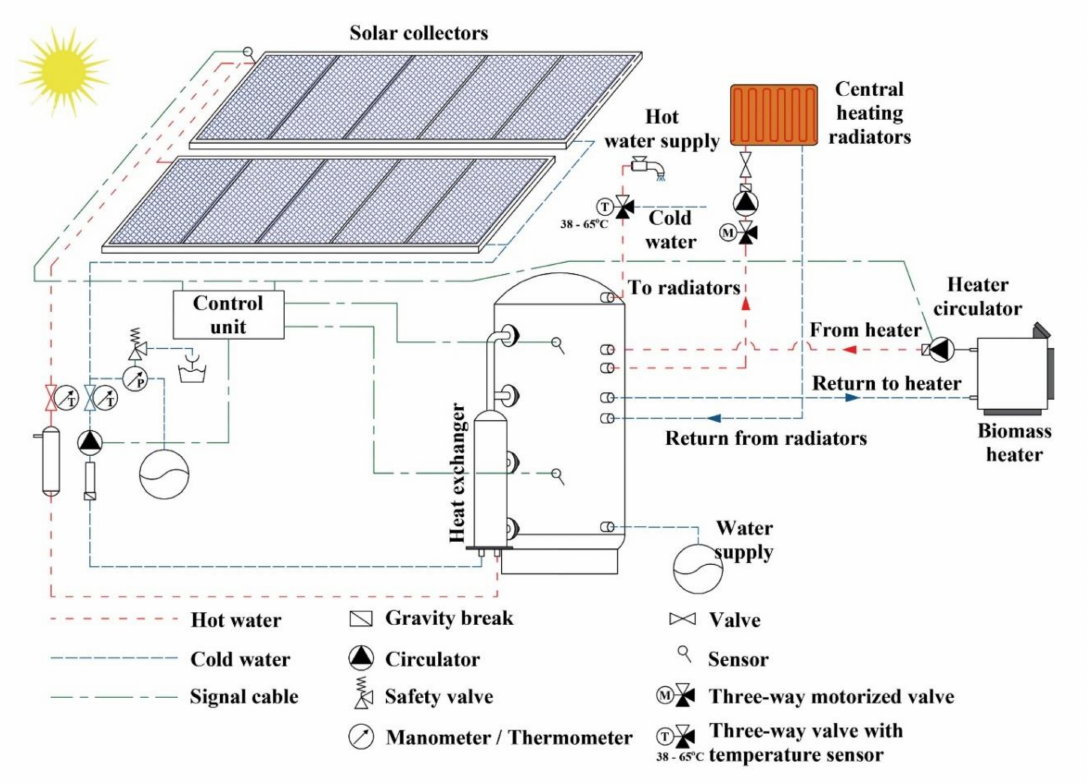
Figure 7. General layout of a solar-combi